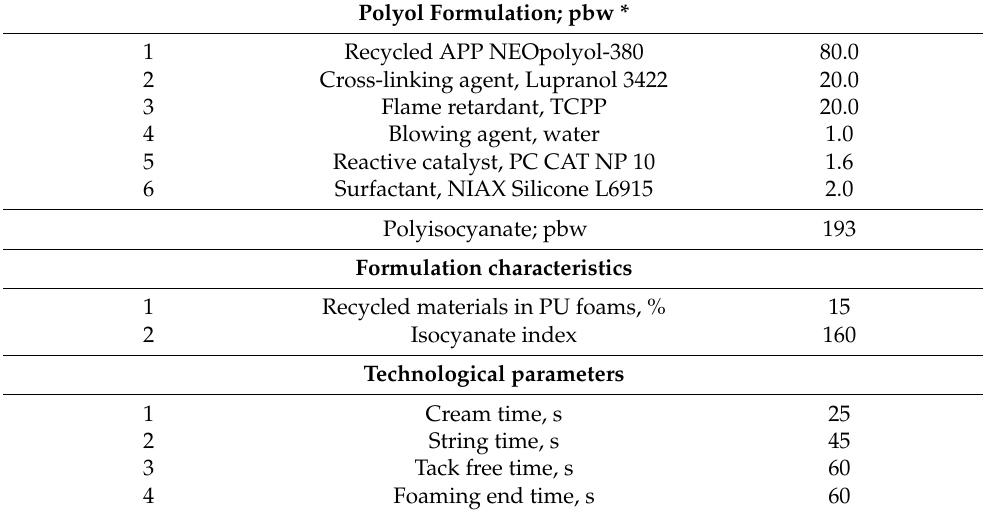
Table 1. The formulation of the PU